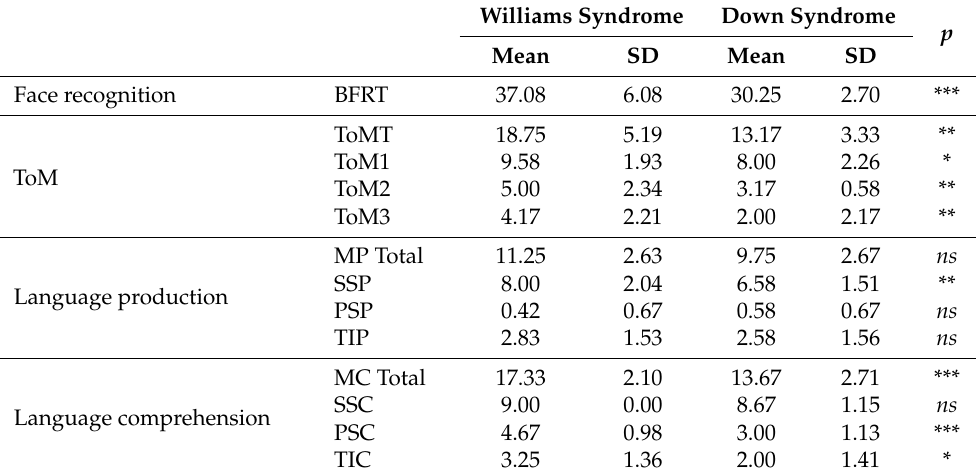
Table 2. Mean scores for participants with WS and DS on the three